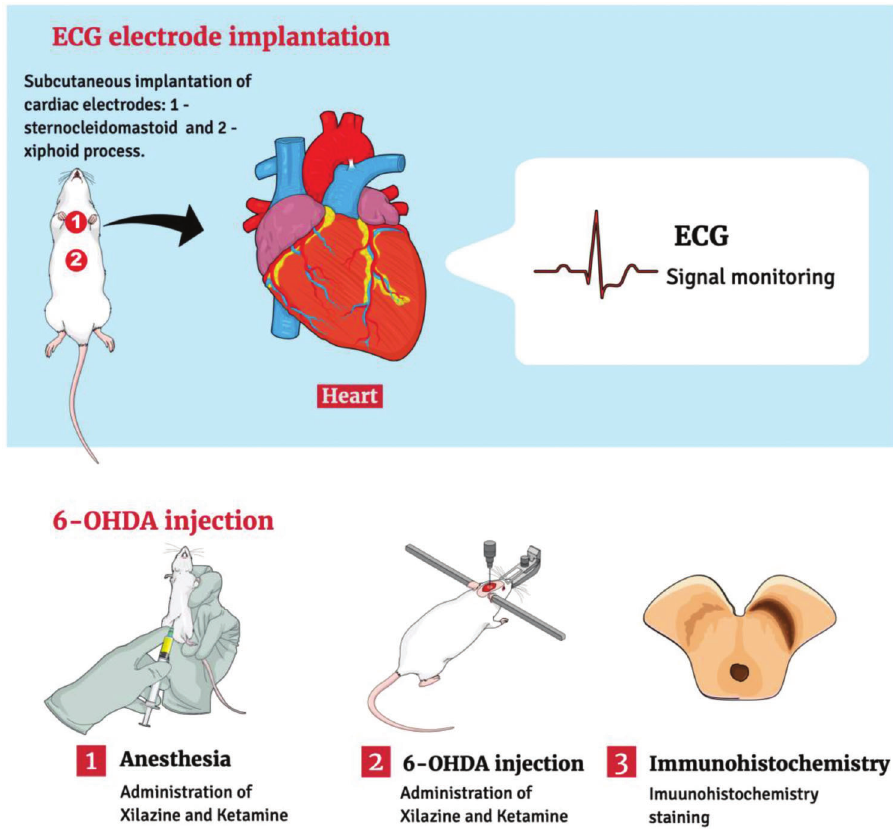
Figure 1 - Schematic representation of the experimental procedures 6-OHDA, 6-hydroxydopamine; ECG,